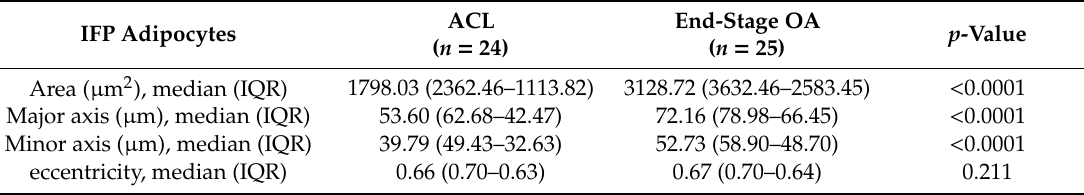
Table 2. Infrapatellar fat pad adipocytes